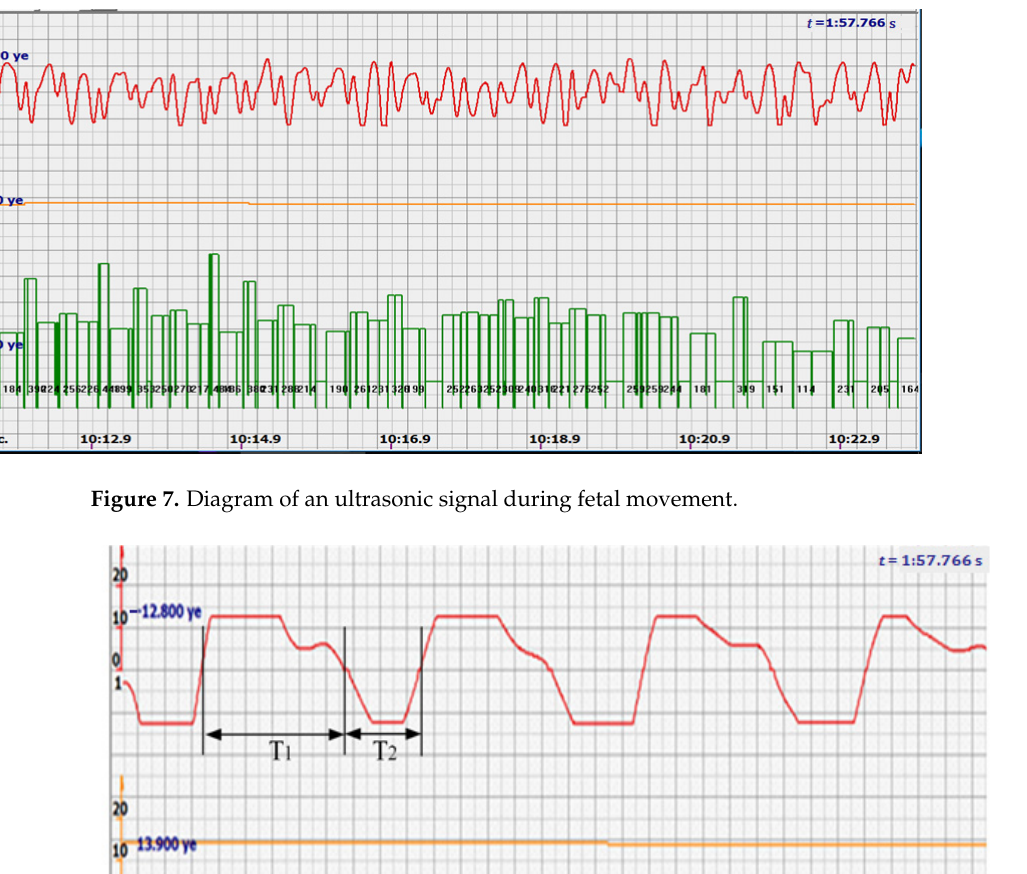
Figure 6. Diagram of heart rate calculations using the spectral method.